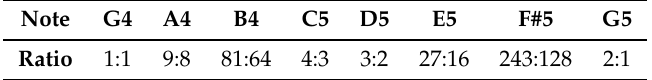
Table 2. One octave of the Pythagorean scale of G major.